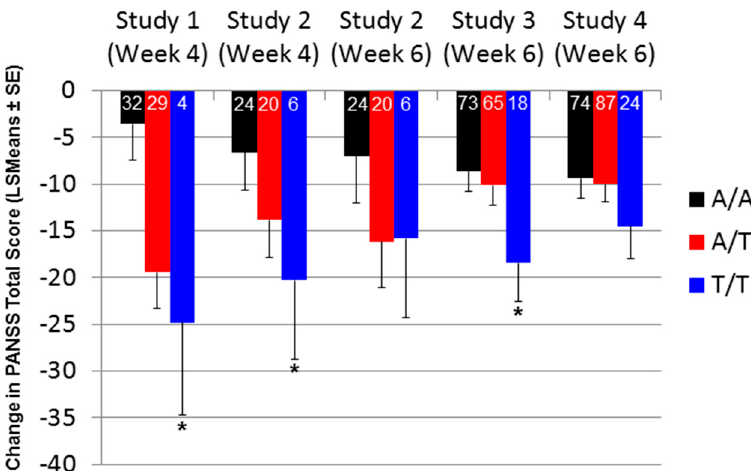
Figure 2. Change in PANSS total score by the HTR2A SNP rs7330461 genotype in Caucasian patients treated with pomaglumetad methionil 40 mg BID in four different studies. Abbreviations: BID = twice daily; HTR2A = serotonin 2A receptor ( HTR2A ) gene; LSMeans = least squares means; PANSS = Positive and Negative Syndrome Scale; SE = standard error; SNP = single nucleotide polymorphism. Numbers in the bars indicate the number of patients with PANSS measures included in the analyses. * p ≤ 0.05, two-sided p -value, testing is based on comparing A/A versus A/T versus T/T for Study 1; one-sided p- value for Studies 2, 3 and 4.